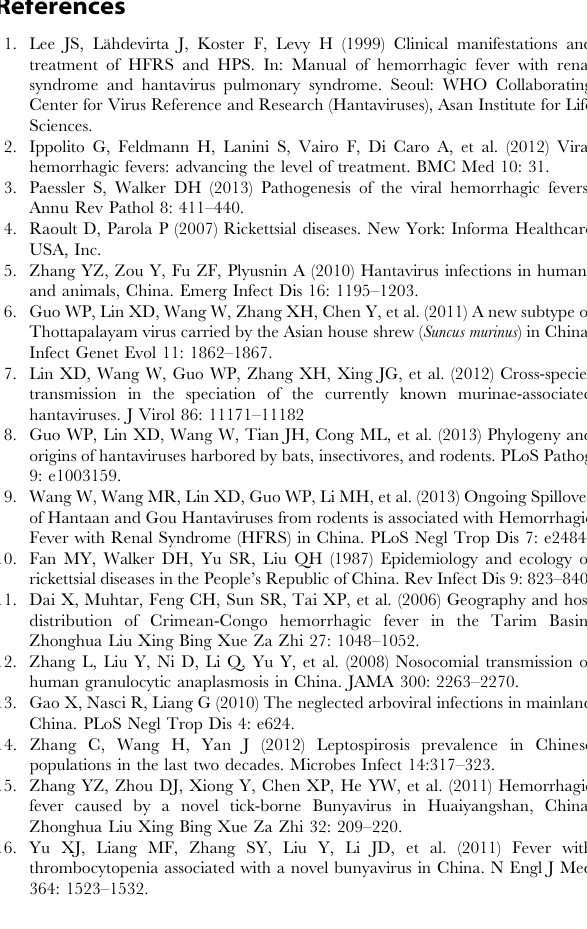
Figure S2 The seasonal distribution of HYSHF and HFRS cases reported during 2011–2012 in Dandong. The color code is the same as Figure 3. Table S1 The clinical and laboratory criteria listed by the Ministry of Health, China for HYSHF, HFRS, murine typhus, scrub typhus, and other related diseases. Table S2 The viral and bacterial sequences recovered in this study and those taken from GenBank. Table S3 Dynamic profile of the body temperature, WBC, and PLT in patients with HYSHF, HFRS, and undetermined infections. Table S4 Dynamic profile of the ALT, AST, GGT, CK, LDH, HBDH, BUN, and CREA in patients with HYSHF, HFRS, and undetermined